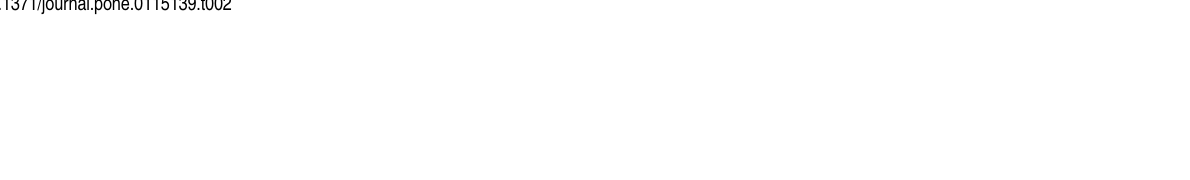
T3 (end of general anesthesia